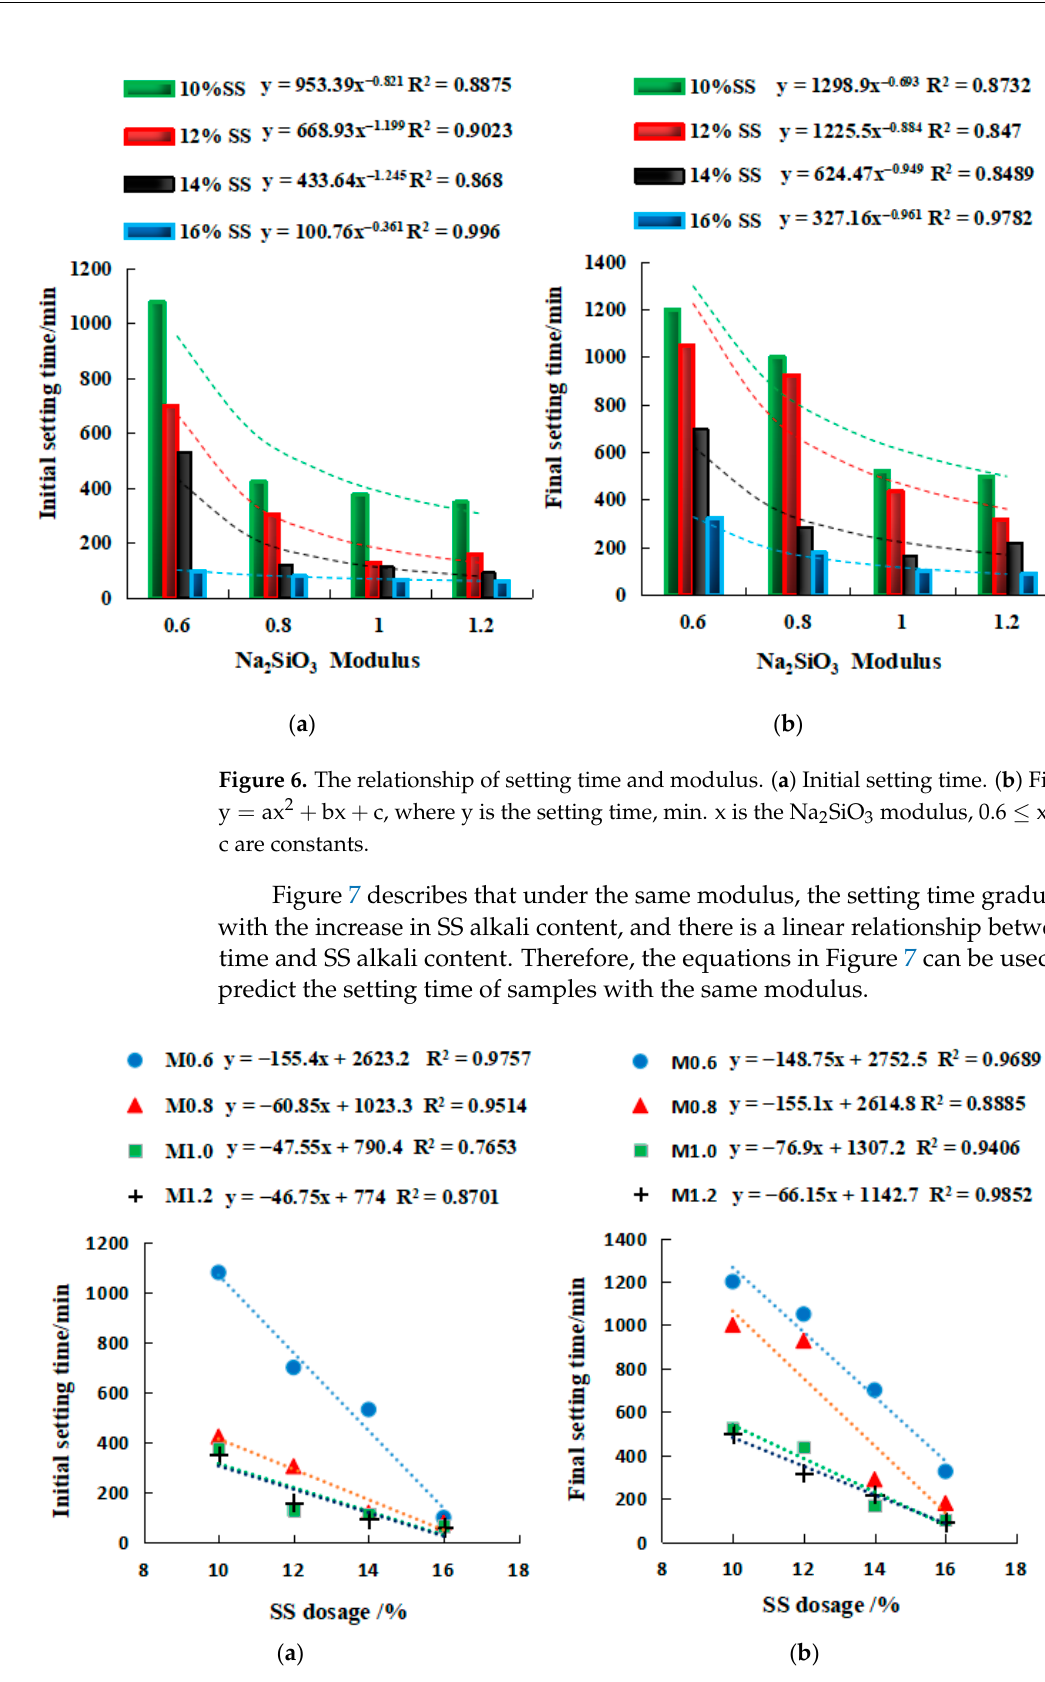
Figure 7. The relationship of setting time and SS dosage. ( a ) Initial setting time. ( b ) Final setting time. y = − ax + b, where y is the setting time, min. x is SS activator dosage, 10 ≤ x ≤ 16%. a and b are